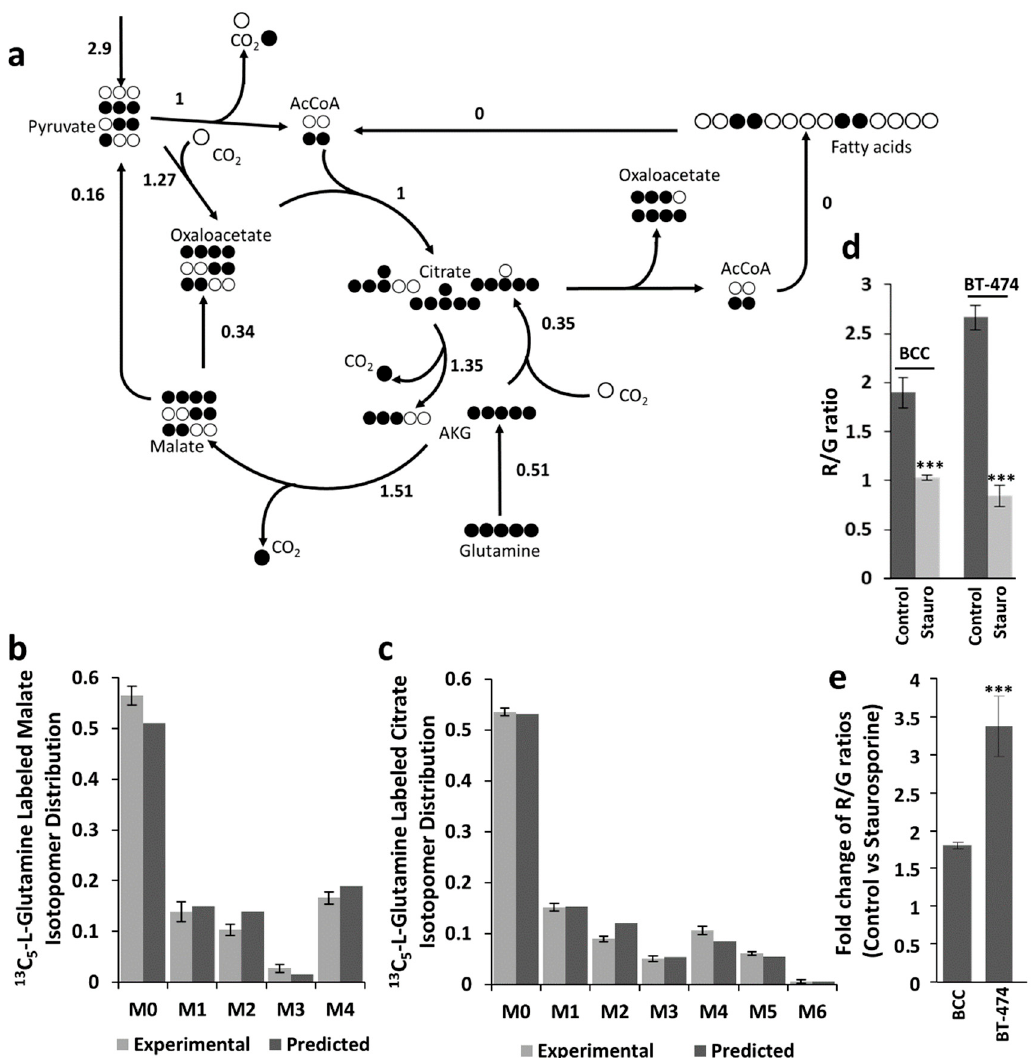
Figure 4. Estimated metabolic flux distributions and labeling patterns (simulated and experimental) of malate and citrate for BT-474 cells. ( a ) Estimated metabolic flux distributions for BT-474 cells. Simulated and observed labeling patterns of malate ( b ) and citrate ( c ). Error bars represent 95% confidence intervals (n = 4). ( d ) Staurosporine-induced mitochondrial depolarization in BT-474 and BCC cells. ( e ) Fold change of R/G ratios in BCC and BT-474 cells after staurosporine treatment. Bar graphs represent mean ± SEM (n = 4), *** p < 0.001.